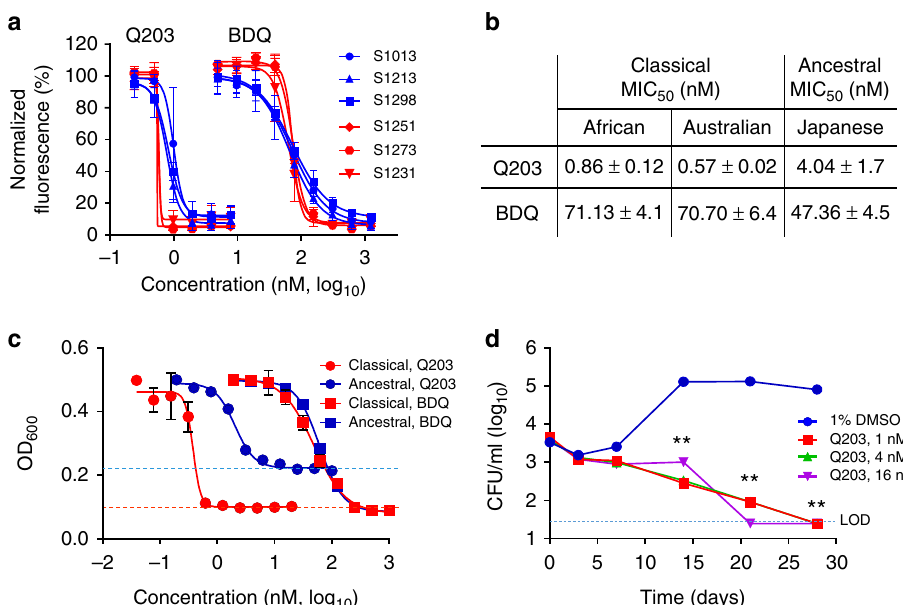
Fig. 2 Potency of drugs targeting the cyt- bc 1 :aa 3 against M. ulcerans . a Growth inhibitory activity of Q203 and bedaquiline (BDQ) against classical M. ulcerans clinical isolates from Africa (blue symbols) and Australia (red symbols) replicating in culture broth medium using a resazurin-based assay. Data are expressed as the mean ± s.d. of triplicates for each concentration. b Growth inhibitory activity (MIC 50 ) of Q203 and BDQ against classical strains from African and Australian origin, and against ancestral strains from Japanese origin. MIC 50 values are the average of three strains, each tested in duplicate. c Growth inhibitory activity of Q203 and bedaquiline (BDQ) against the classical strain S1013 (red symbols) and the ancestral strain S1325 (blue symbols) replicating in culture broth medium using a turbidity-based assay. Data are expressed as the mean ± s.d. of triplicates for each concentration. The red dotted line shows the bottom plateau for the dose – response curve for bedaquiline and Q203 against the classical strain; the blue dotted line shows the bottom plateau of the dose – response curve for Q203 against the ancestral strain. d Bactericidal potency of Q203 against the classical strain S1013 replicating in culture broth medium. Q203 was tested at a concentration of 1, 4, and 16 nM in triplicate and repeated once. The dotted line represents the limit of detection. ** P value <0.001, using the Student's t test, between the untreated control group (1% DMSO) and Q203 at either 1, 4 or 16